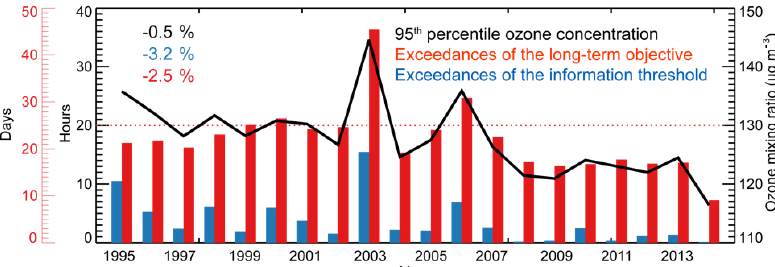
Figure 6. Annual exceedances of the information threshold (for blue bars, hours should be multiplied by 100, 1-hourly averages: 180µgm − 3 ) as well as the long-term objective (red bars, maximum diurnal 8-hourly mean: 120µgm − 3 ) , compared with the annual 95th percentile ozone concentrations (black line). The red dotted line shows the target value (long-term objective that should not be exceeded more than 25 days per year, averaged over 3